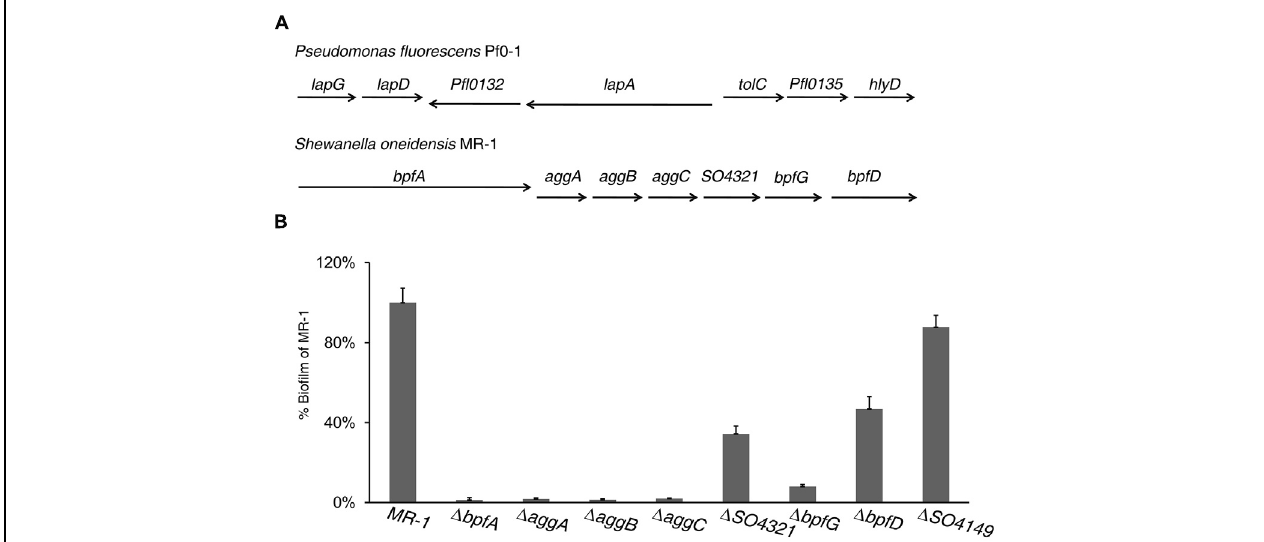
FIGURE 1 | Identification of a cluster of genes involved in biofilm formation in Shewanella oneidensis MR-1. (A) Arrangement of genes in the lapA operon of Pseudomonas fluorescens Pf0–1 and their homologous in MR-1. The type I secretion system (TISS) is formed by ORF tolC–Pfl0135–hlyD in Pf0–1 and aggA–C ( SO4318–SO4320 ) in MR-1. The ORFs SO4321 , SO4322 ( bpfG ), and SO4323 ( bpfD ) encode an OmpA-like protein, a TISS associated periplasmic transglutaminase-like